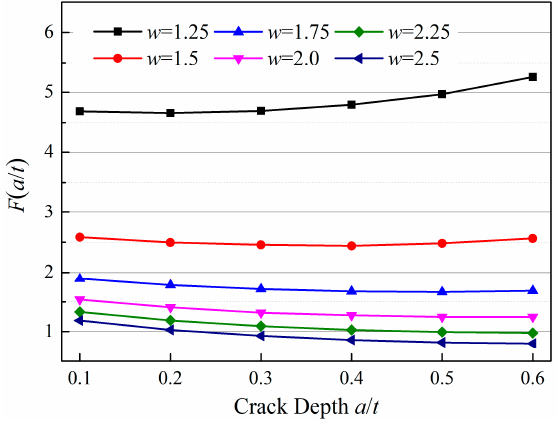
Figure 6. Trend of the correction factor F ( a/t ) with the crack